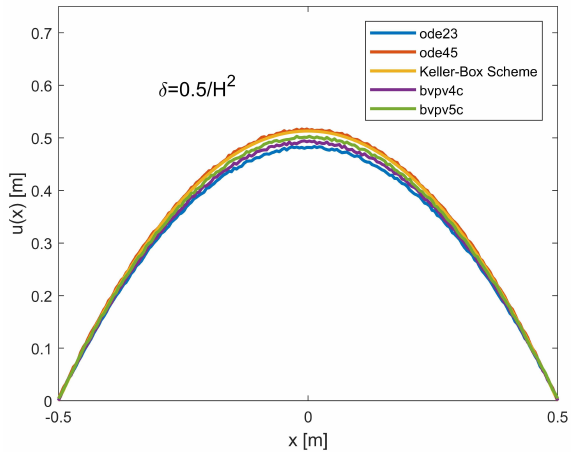
(in convergence conditions and without ghost solutions). H 2